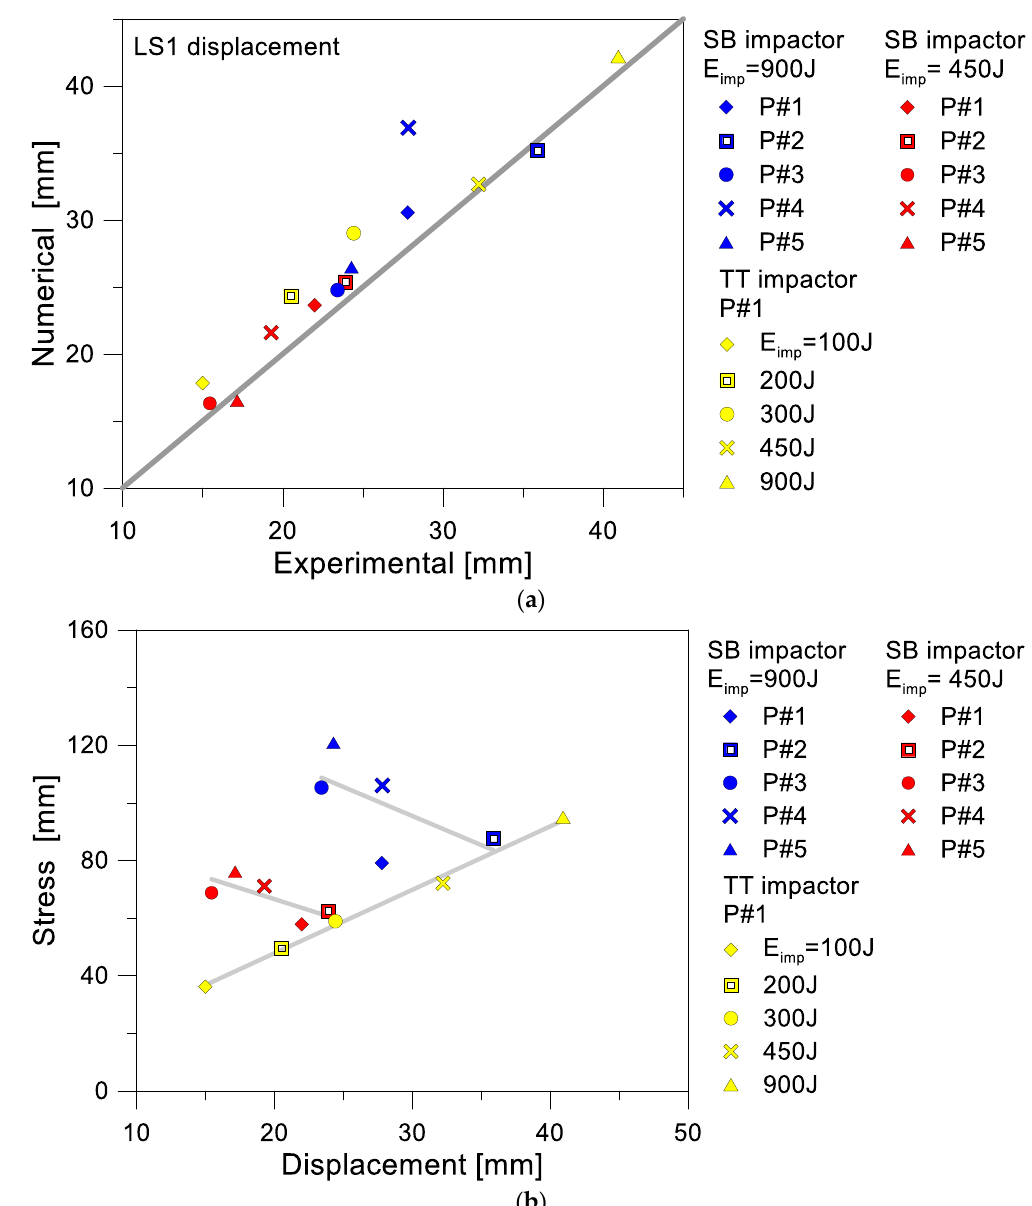
Figure 17. Numerical response analysis (Code Aster): ( a ) displacement peaks (LS1) for the curtain wall under various impact conditions, as a function of the experimental measurements, and ( b ) stress-displacement peaks (glass panel exposed to impact).